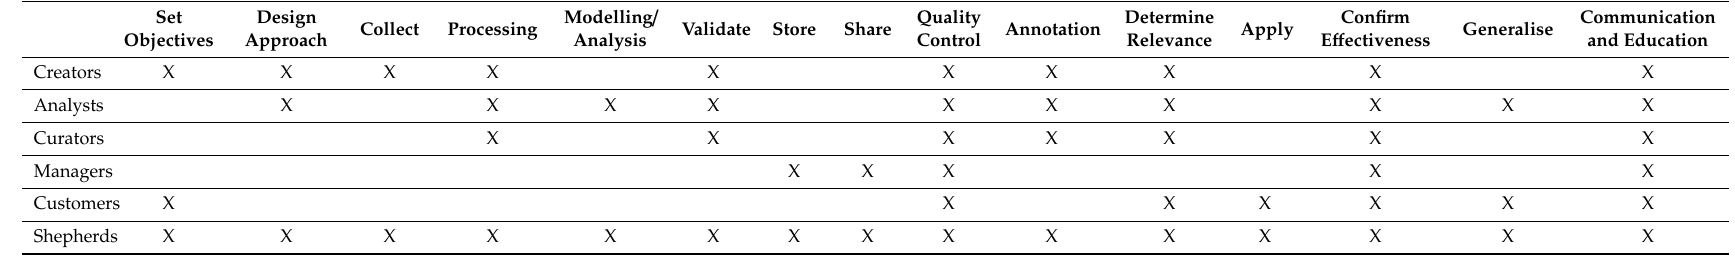
Table 1. Data roles, responsibilities and interactions. Adapted from Hoover et al. [30,41] and Woodall et al. [42]. Adapted with permission from Elsevier, License Number: 4926970512437.